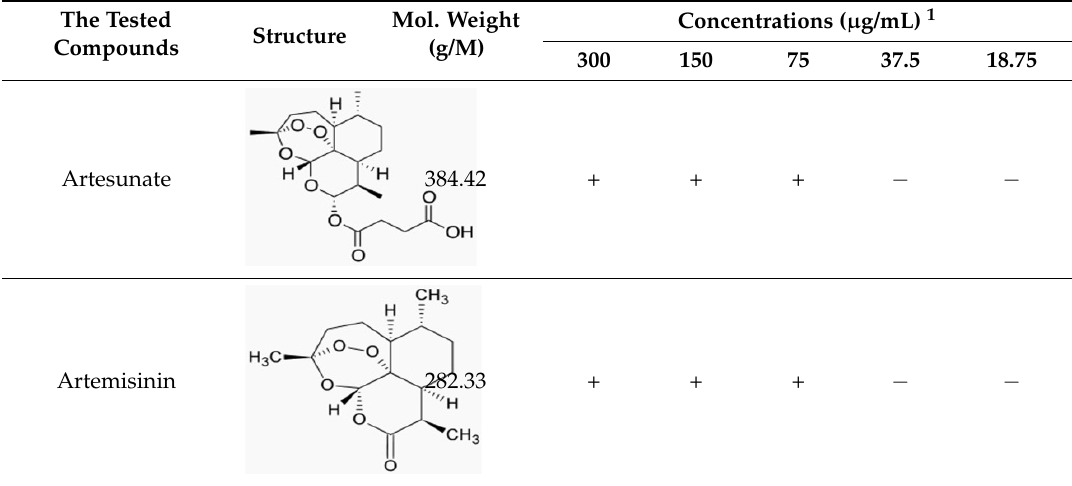
Table 1. The anti-Mtb activity of artesunate and artemisinin against Mtb H37Rv measured by the REMA assay.